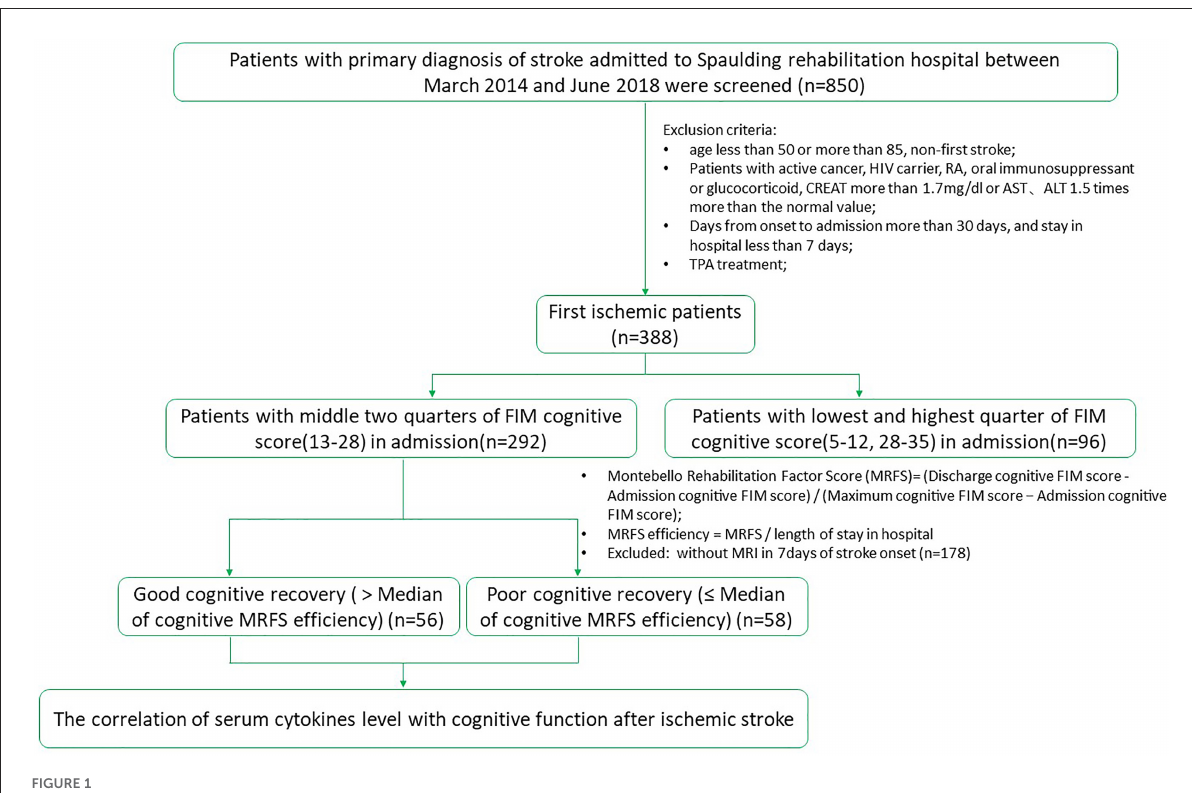
FIGURE1 Study flow